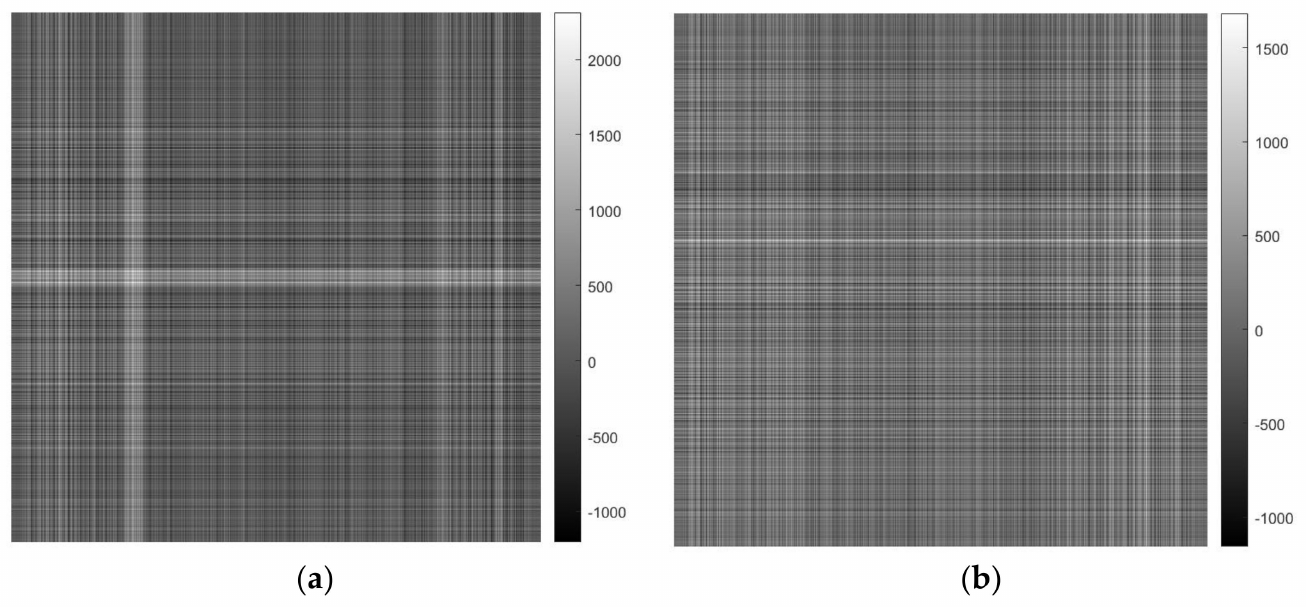
Figure 17. Results of slit scanning method. 5 mg/mL: ( a ); 0.5 mg/mL: ( b ).